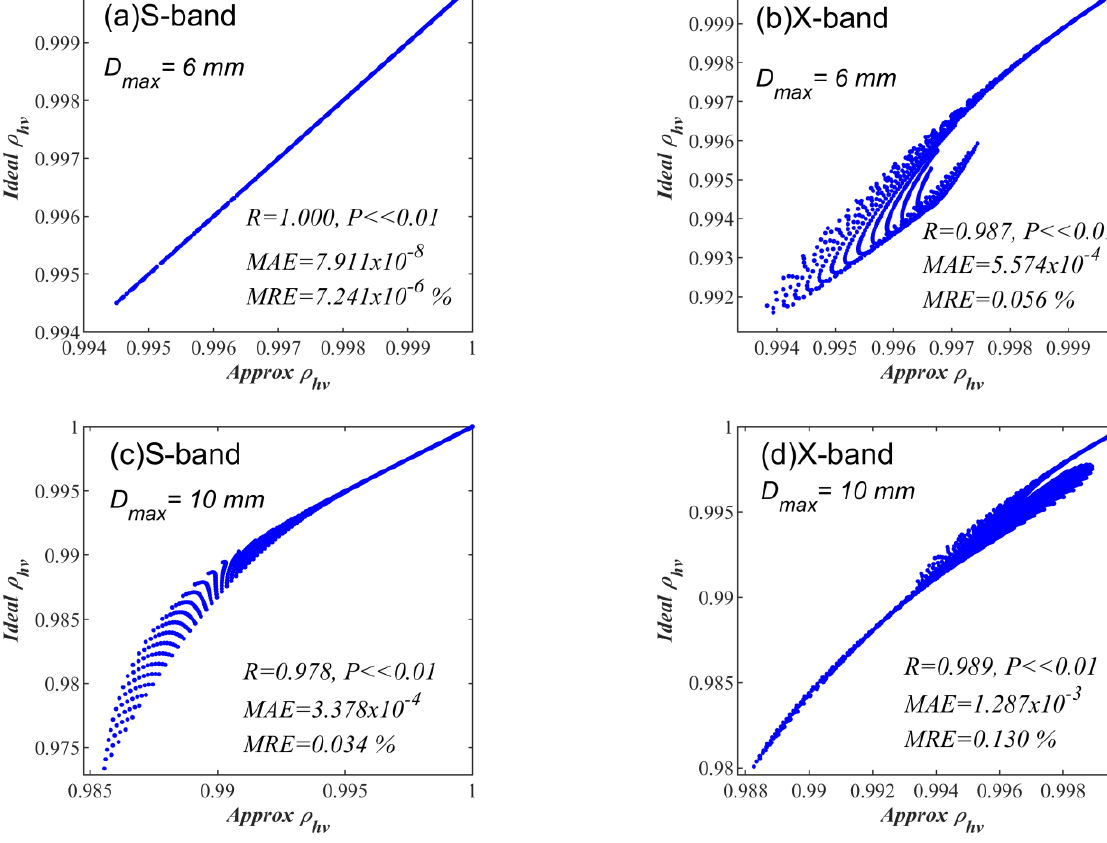
Figure 5. Relationships between approximate ρ hv in this study and ideal ρ hv in raindrops. (The values of D 0 are from 0.1 mm to D max in 0.1 mm intervals. The values of µ range from − 0.8 to 16 in intervals of 0.2. R is the correlation coefficient between the approximate ρ hv and ideal ρ hv enumerated samples, and P is the significance of R. MAE is the mean absolute error, and MRE is the mean relative error. See Appendix A). ( a ) S-band and D max = 6 mm, ( b ) X-band and D max = 6 mm, ( c ) S-band and D max = 10 mm, ( d ) X-band and D max = 10 mm.